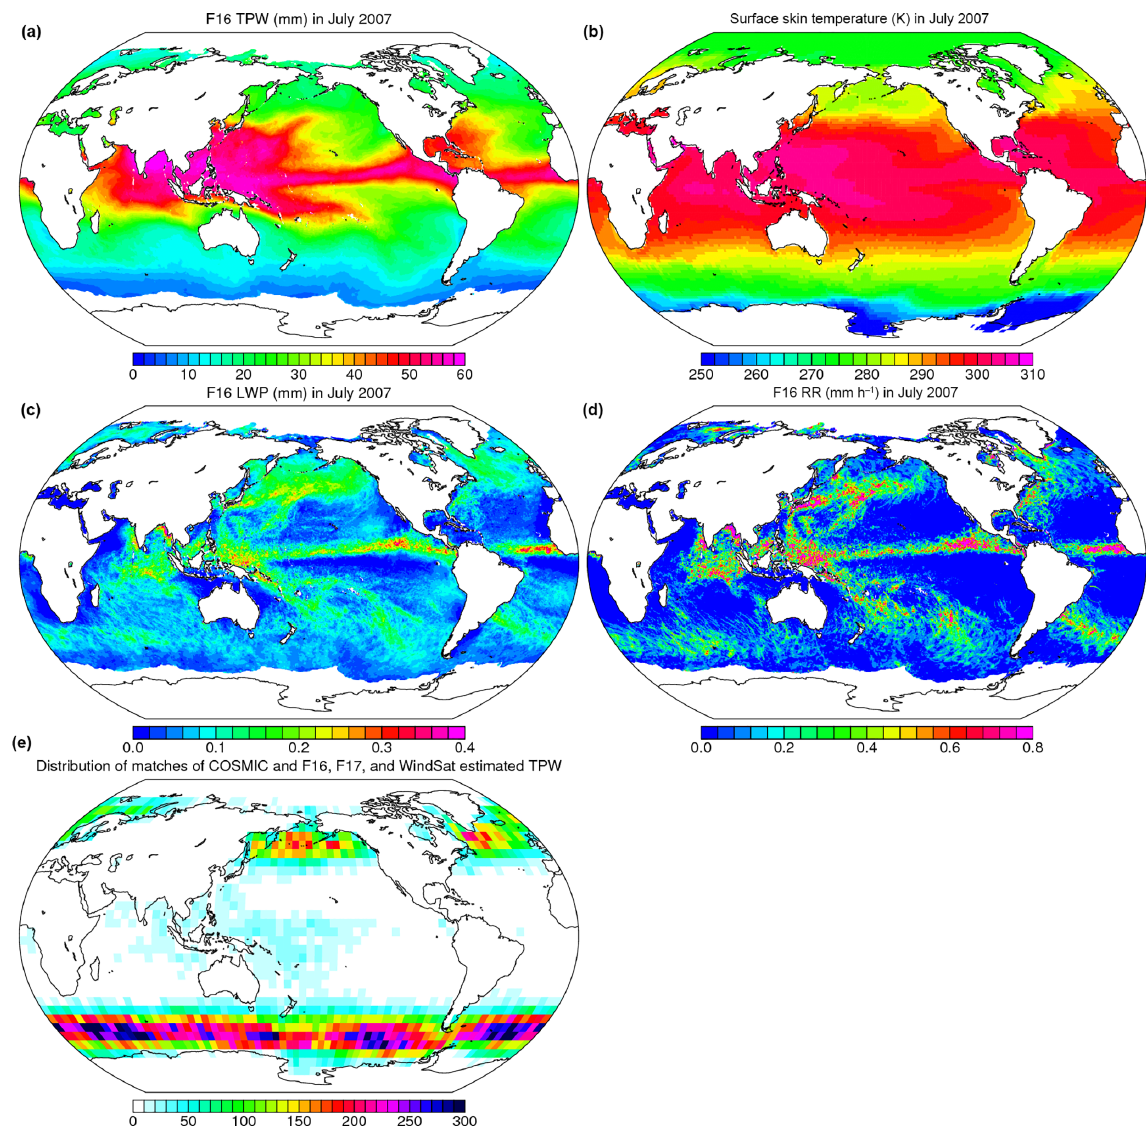
Figure 1. (a–e) The RSS v7.0 monthly mean F16 SSM/I (a) TPW (mm), (b) surface skin temperature (K), (c) liquid water path (LWP, mm), and (d) rain rate (RR, mmh − 1 ) and (e) distribution of matches of COSMIC RO and F16, F17, and WindSat estimations of TPW used in this